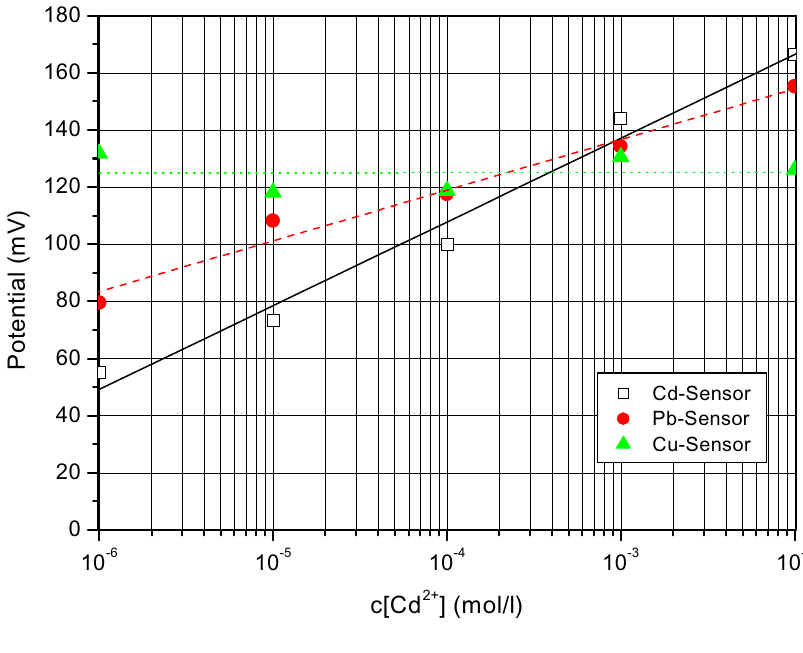
Figure 7. Calibration curves of the single sensors of the thin-film sensor array towards Cd2+-